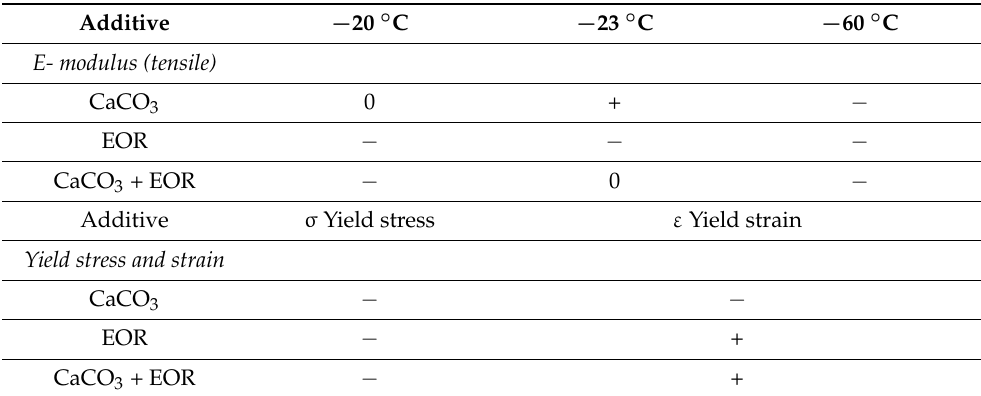
Table 3. Trends in the mechanical properties of rPP with the addition of elastomer EOR and CaCO 3 or both. Reproduced with permission